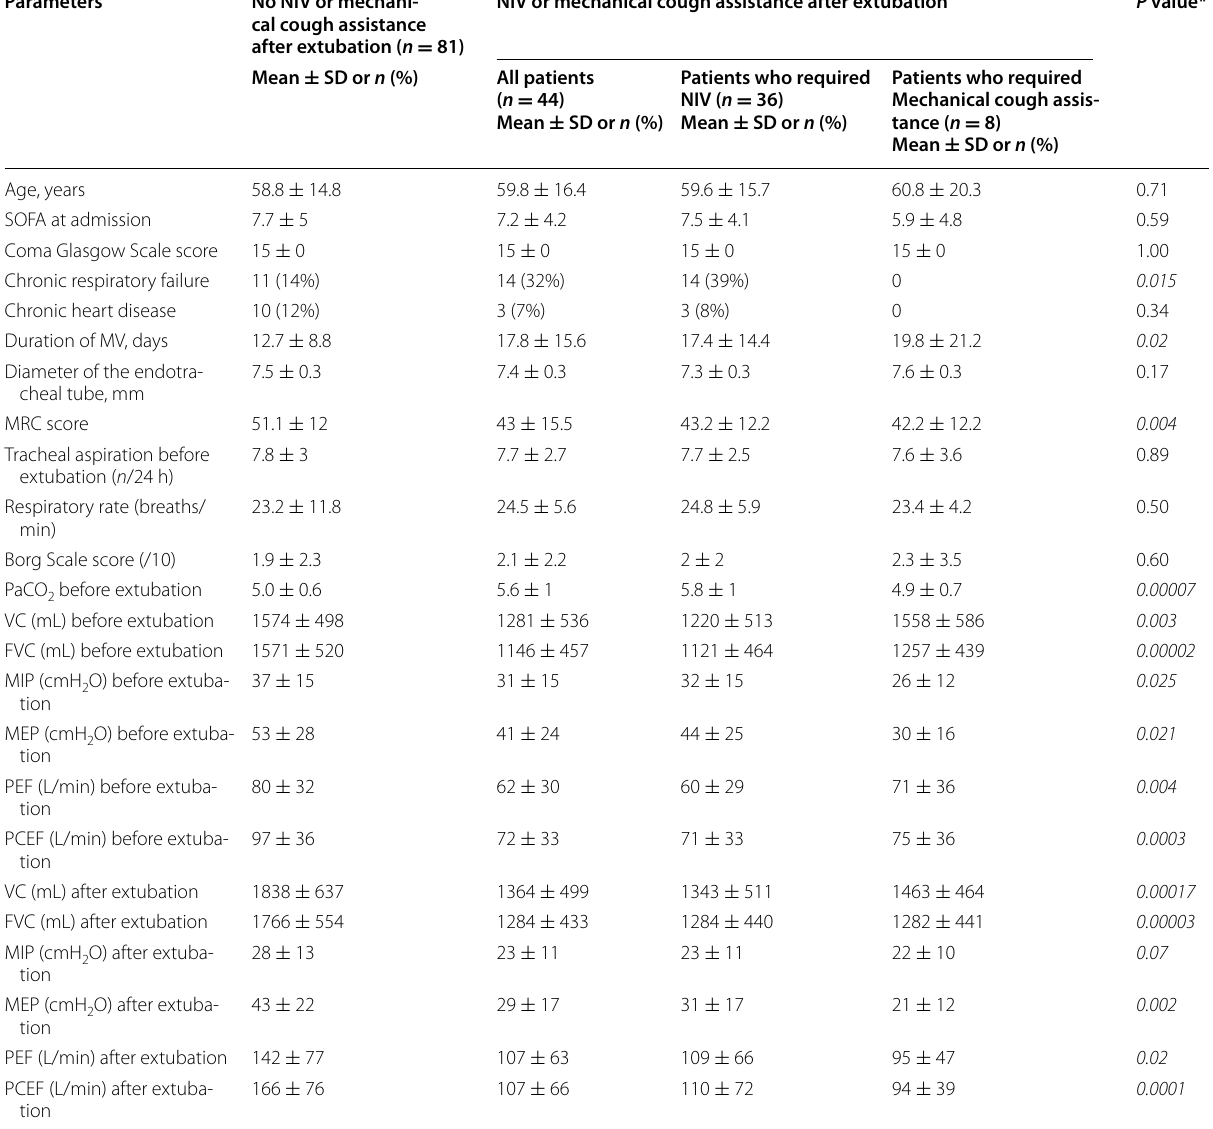
Table 3 Univariate